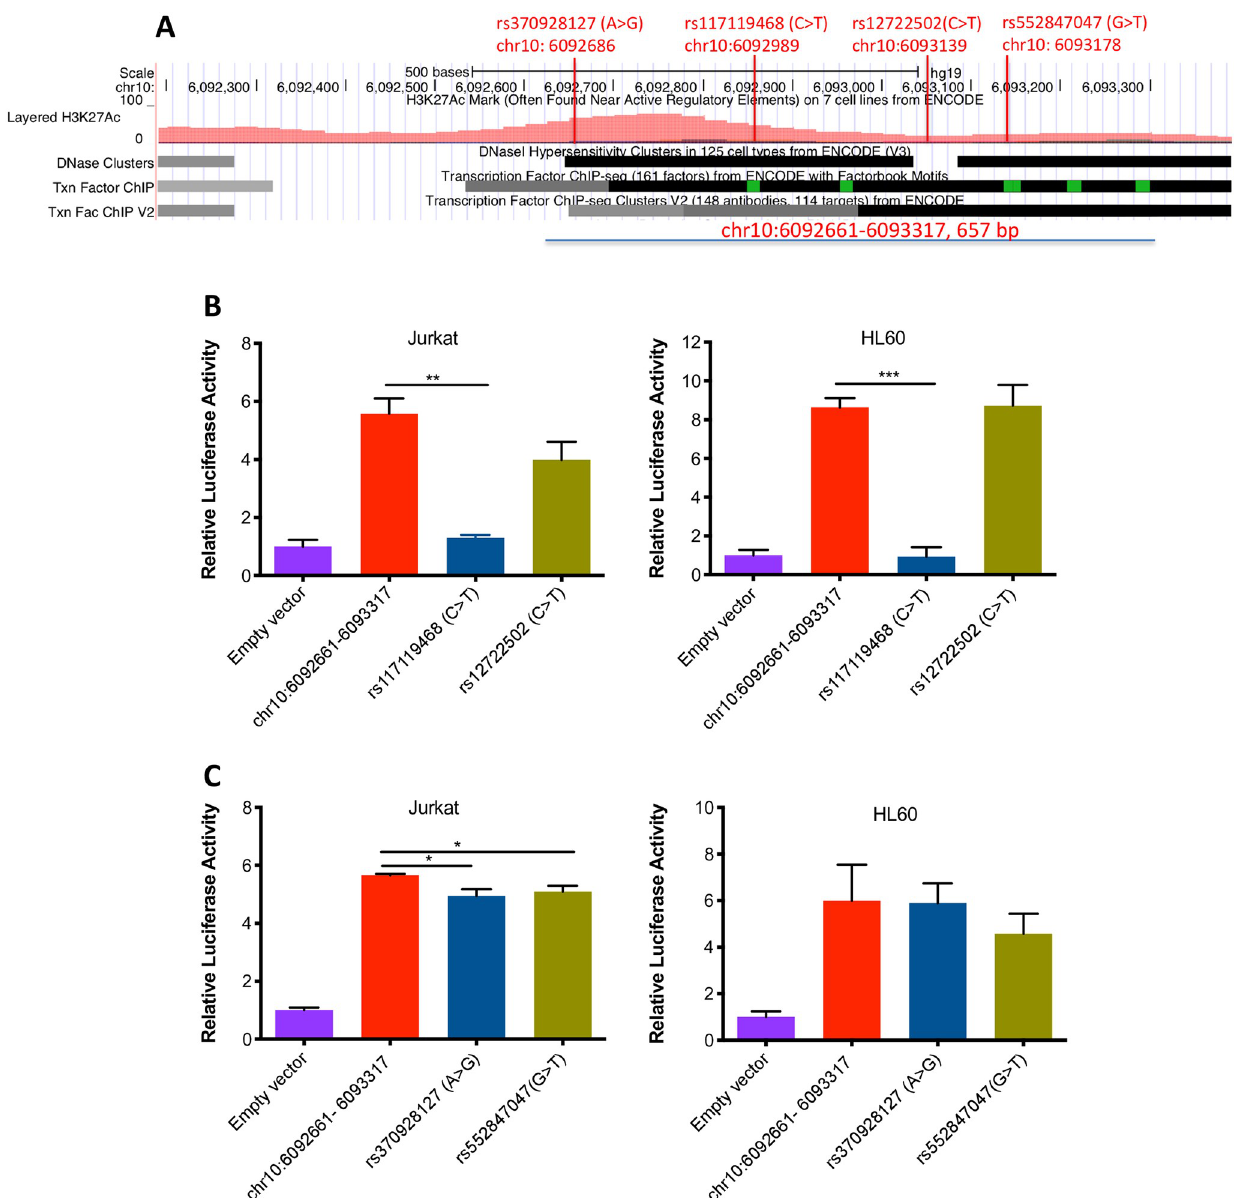
Fig 6. The effects of JIA-associated genetic variants (IL2RA locus) on enhancer activity in Jurkat T cells and in HL60 cells. A. The construct within 657 bp region (chr10:6092661–6093317) within the first intron of the IL2RA gene was used as template to generate 4 enhancer genetic variants. Of the 4 variants, rs117119468 (C- > T), and rs12722502 (C- > T) had identified on whole genome sequencing (WGS) of a small number of children with polyarticular JIA [39]; rs370928127 (A > G) and rs552847047 (G > T) were common genetic variants annotated in the 1000 Genomes Project data. B. The second bar represents results from the region queried within a 657 bp region within the first intron of the IL2RA gene. This variant, rs117119468 (C- > T), almost completely abolishes enhancer function in Jurkat T cells and in HL60 cells (third bar). A second variant, rs12722502 (C- > T), reduced luciferase production in Jurkat cells but not in HL60 cells (fourth bar). C. Bar graph showing the effects of two additional variants annotated in the 1000 Genomes Project data, rs370928127 (A > G) and, rs552847047 (G > T), on enhancer activity in Jurkat T cells and in HL60 cells. The third and forth bars show these two variants have an effect on enhancer activity in Jurkat but not in HL60 cells. The empty vector (negative control) is the basic pGL4.23 vector (which contains the SV40 promoter but is inefficient at driving luciferase expression). Data are represented as mean ± SEM of 3 biological replicates, and p values are calculated using Student’s t test. � p � 0.05; �� p � 0.01; ��� p �